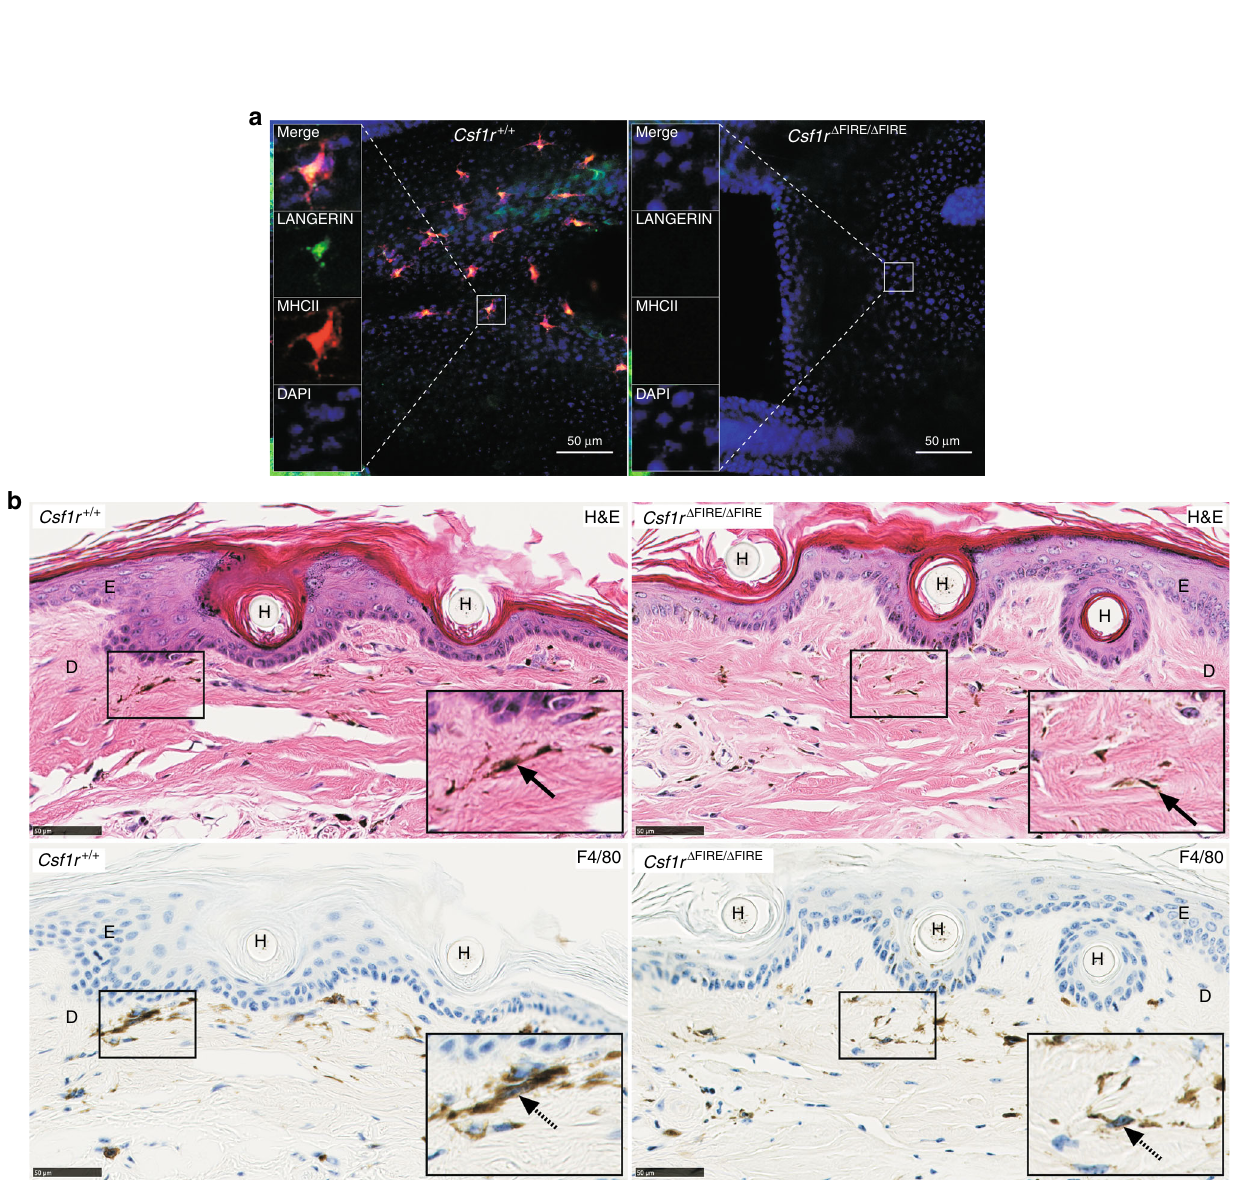
Fig. 6 The deletion of FIRE results in loss of Langerhans cells. a Whole-mount epidermal tail sheets were stained with antibodies against LANGERIN (green) and MHCII (red). Nuclei were stained with DAPI (blue). Images are representative of four mice per genotype, aged between 8 and 10 weeks. Scale bars = 50 µ m. b Decalci fi ed tails from the same cohort of mice above were stained with hematoxylin and eosin (H&E, upper panel) and an antibody against F4/80 (lower panel). E epidermis, D dermis, H hair follicle. Scale bars = 50 µ m